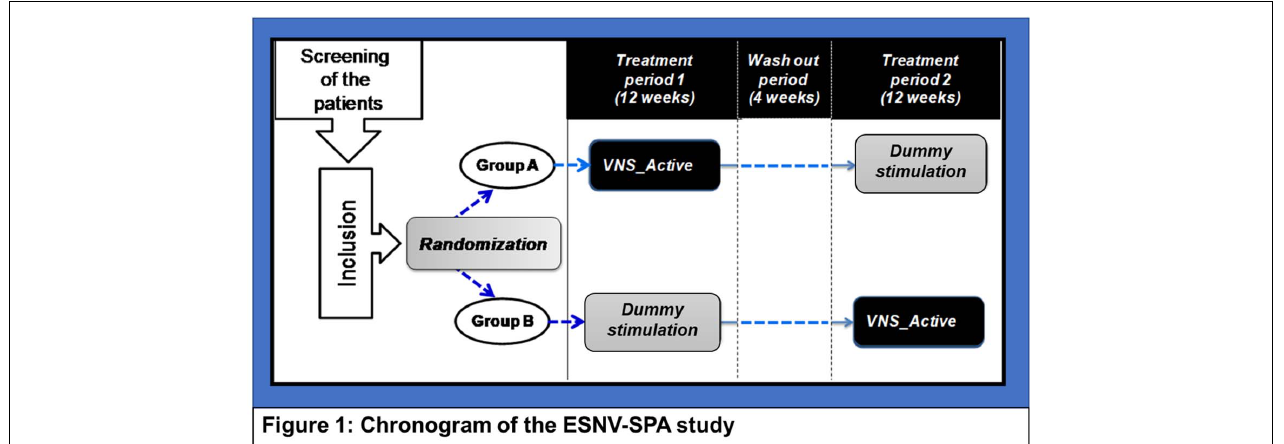
FIGURE 1 | Chronogram of the ESNV-SPA study. Patients randomized in group A will receive active VNS stimulation once a week for 12 weeks starting from the first week after inclusion: Treatment period 1 (TP-1), followed by dummy stimulation for 12 weeks: Treatment period 2 (TP-2). Patients randomized to group B will receive the reverse sequence: weekly dummy stimulation for 12 weeks as TP-1, followed by 12 weeks of active VNS as TP-2. The two stimulation periods will be separated by a 4-weeks wash-out period.